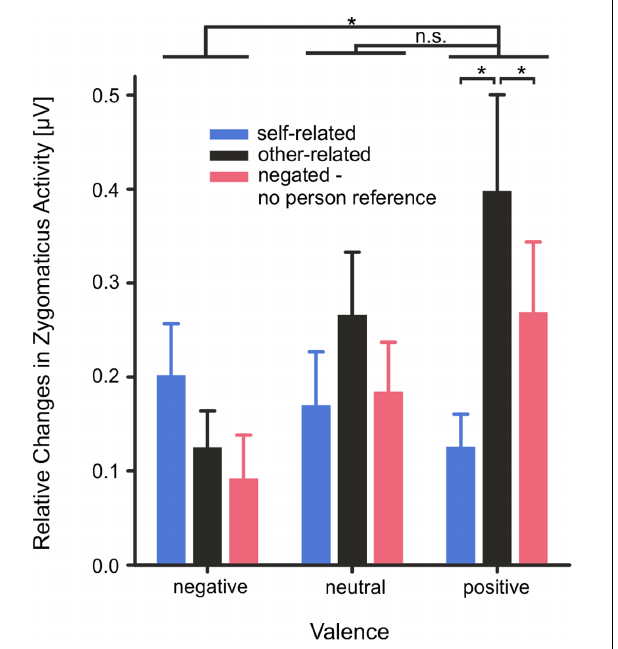
FIGURE 4 | Changes in mean M. Corrugator activity as measured by fEMG depicted as changes in mean activity during the stimulus interval from 0 to 4000 ms. Error bars depict SEM. Changes are illustrated as relative changes from baseline. n.s. p > 0.1, † p = 0.05, ∗ p < 0.05, ∗∗ p < 0.01, ∗∗∗ p < 0.001, FDR corrected.